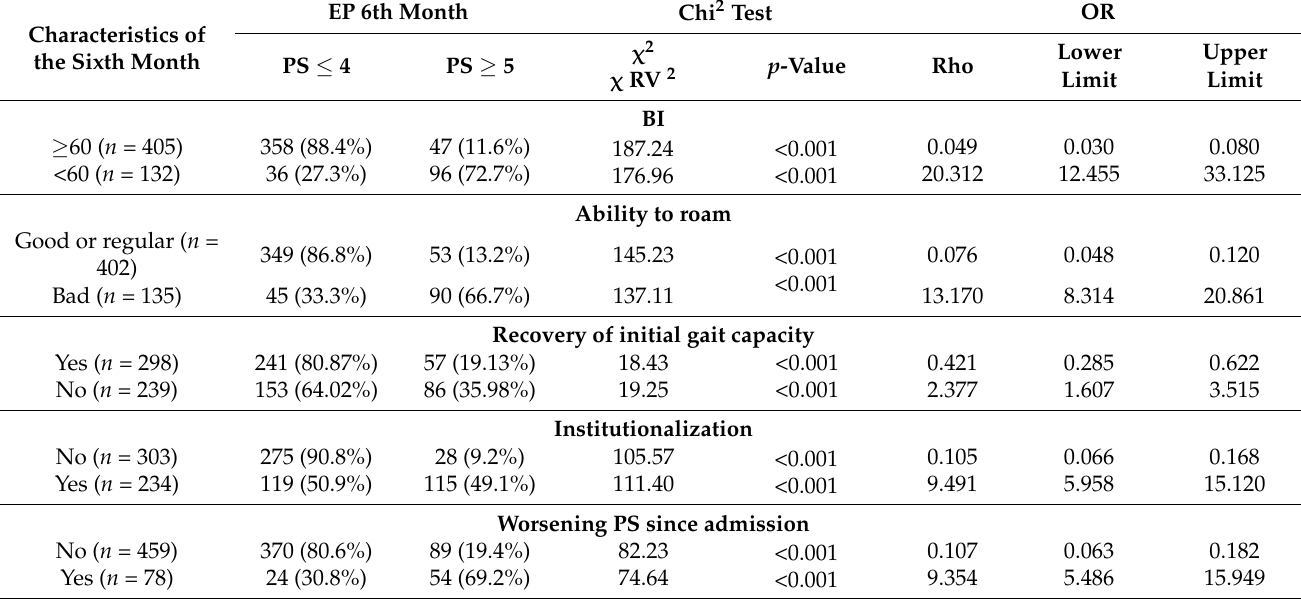
Table 5. Results of the Chi 2 test between the characteristics at the sixth month and its relationship with cognitive